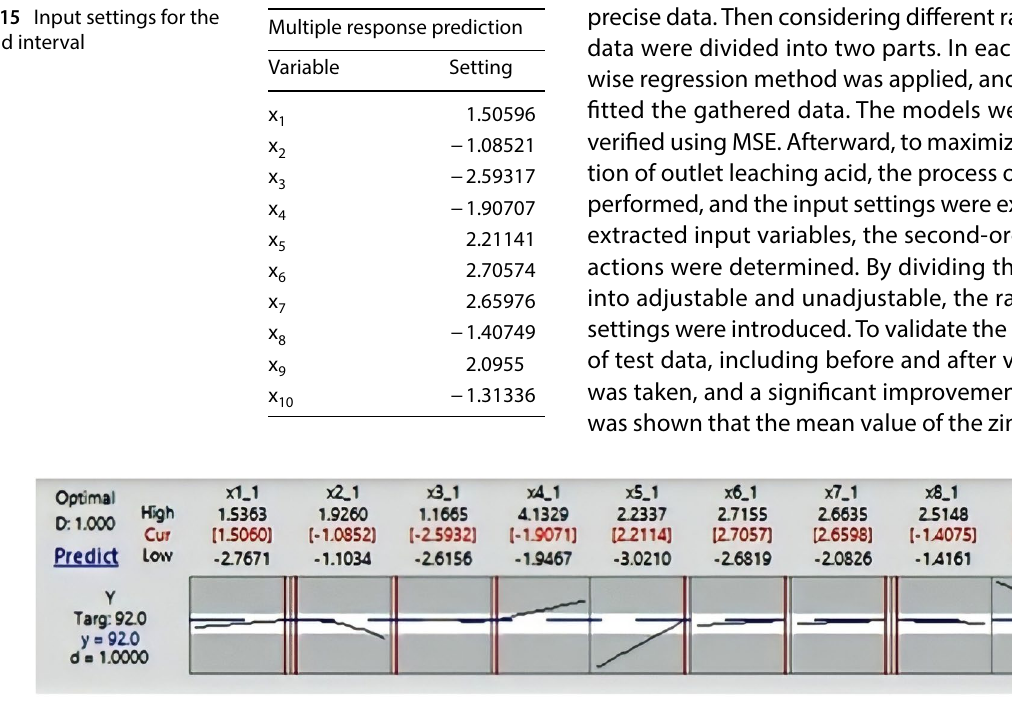
Fig. 11 Optimization plot for the second interval